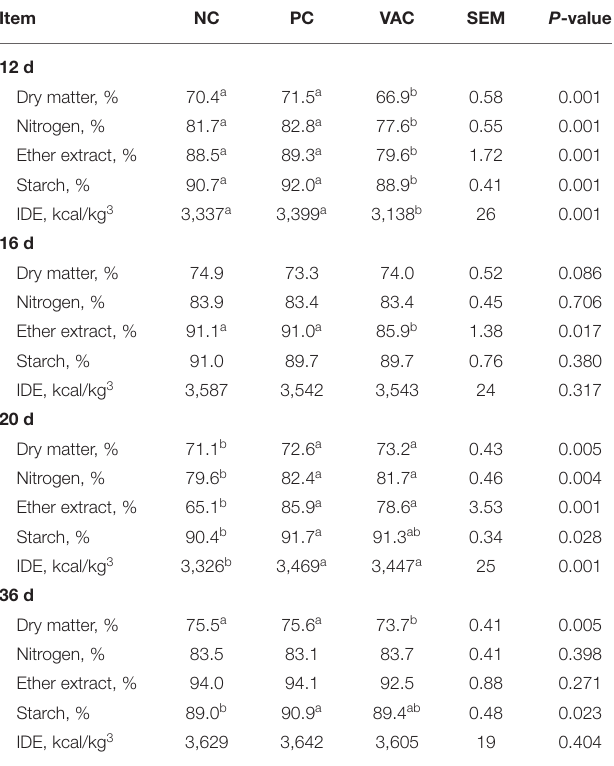
TABLE 4 | Effects of coccidiosis vaccination on the apparent ileal digestibility (%) of nutrients and ileal digestible energy (kcal/kg) in broilers to 36 d post-hatch 1,2